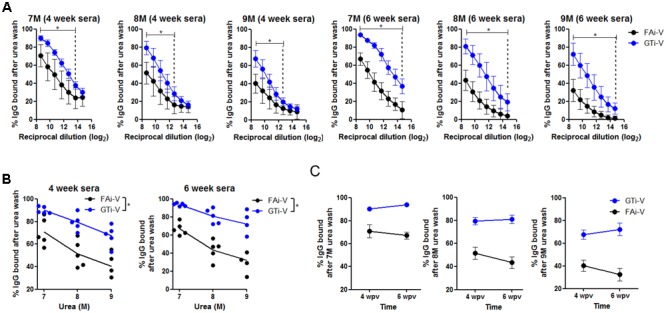
Quality of antibody responses elicited by GTi virus. (A) Comparison of relative avidity of antibodies elicited by GTi virus or FAi virus. 96-well plate wells were coated with PR8 viruses (104 PFU/well), and twofold serial dilutions of antisera to GTi virus or FAi virus (vaccination dose; 2.5 × 106 PFU) were added to the PR8 virus for binding. The wells were then washed with either distilled water (DW) or 7-9 M urea for 30 min at RT. The percentages of IgG antibodies bound after the urea washing were expressed as % OD450 relative to that of DW washing. The vertical dashed lines indicate the lowest serum concentrations that show statistically significant differences between vaccinations with GTi virus and FAi virus. (B) The trends of the antibody avidity at the highest serum concentration along urea concentrations. (C) Maturation of antibody avidity over time after vaccination with GTi virus. Data are the mean of each cohort (n = 5). ∗P < 0.05 when comparing antibody avidity between two different groups.